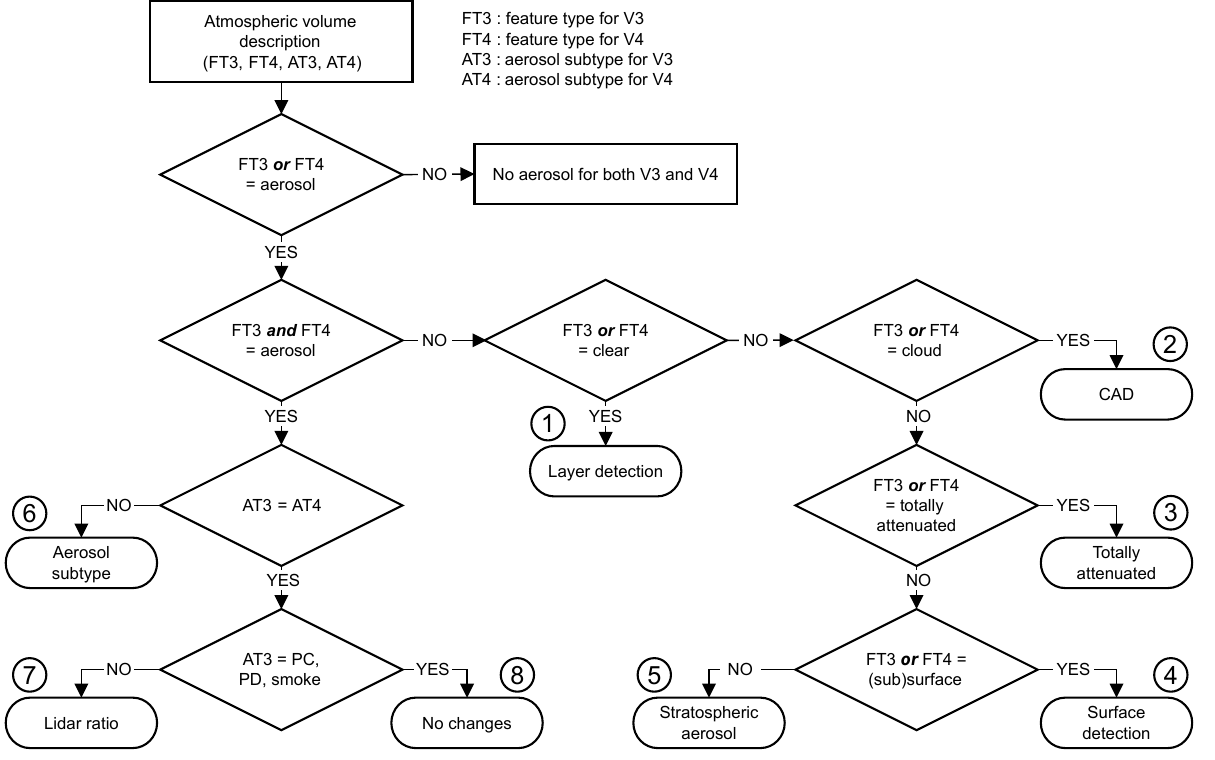
Figure 14. Flowchart to categorize factors that impact the AOD change between V3 and V4. Note that changes between polluted continental and smoke are treated as no changes because the lidar ratios at 532nm for those aerosols are the same (70sr). FT3 and FT4 represent the feature types assigned in V3 and V4, respectively. Similarly, AT3 and AT4 designate version-specific aerosol subtypes. Table 6. Mean column AOD changes ( ± standard deviation) from CALIOP V3 to V4 (defined as V4 – V3) and their bin frequencies for different reasons described in Fig. 5 for all-sky conditions from 2007 to